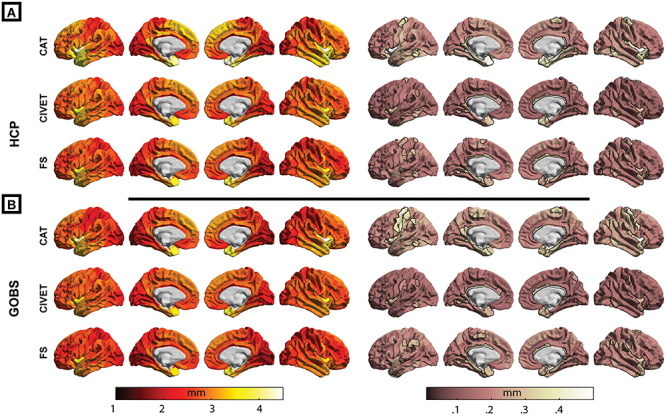
Regional mean (left columns) and SD (right columns) of cortical thickness estimates of each pipeline. For each pipeline, parcels with the highest SD (top 10%) are depicted with a black surrounding.